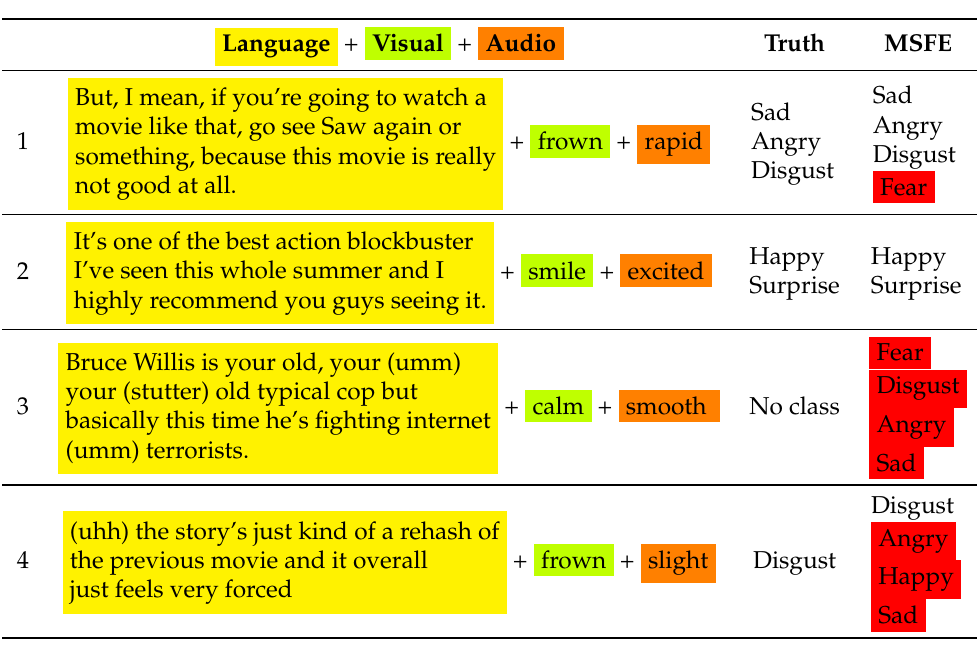
Table 5. Example from the CMU-MOSEI dataset. The true emotional label lies between the six emotional labels. MSFE outputs the predicted label type. Yellow , Lime and Orange represent text information, visual information and audio information, respectively. Red indicates misclassified